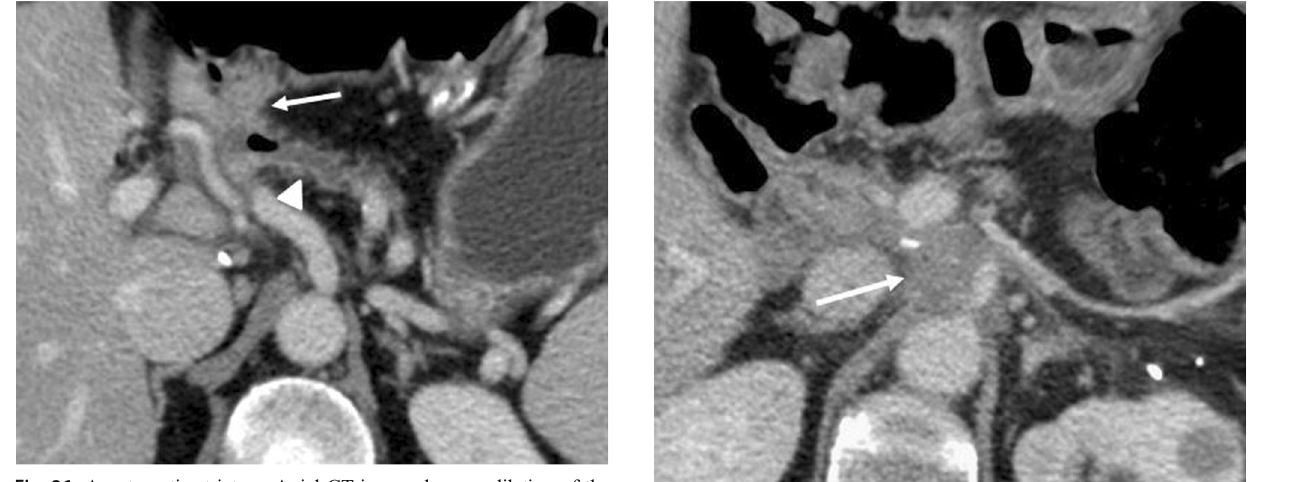
Fig. 26 Anastomotic stricture. Axial CT image shows a dilation of the main pancreatic duct associated with atrophy of the pancreatic parenchyma (white arrowhead). No signs of local tumour recurrence are seen at the pancreatic anastomosis (white arrow)